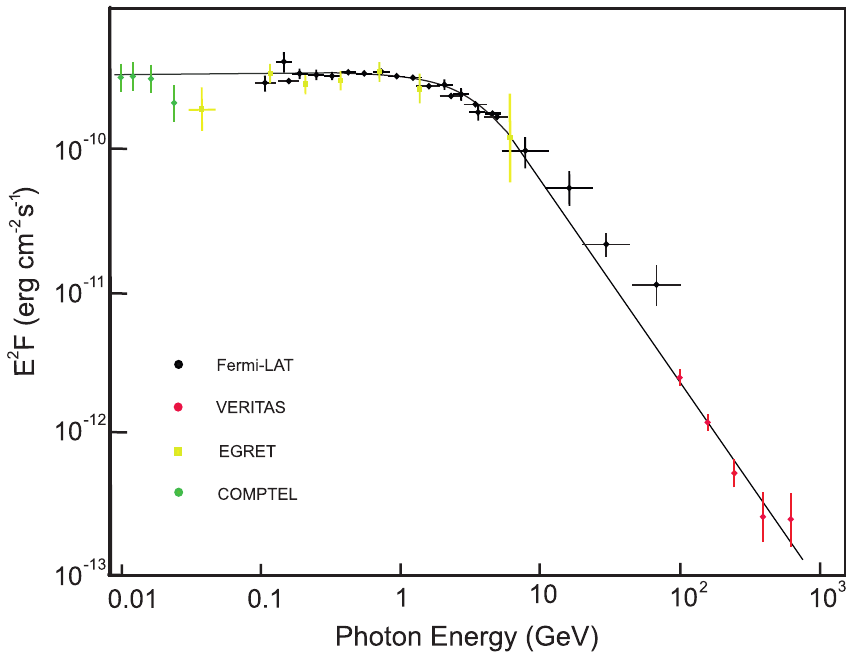
Figure 4. Phase-averaged SED of the Crab pulsar. The black curve represents the broken power-law function with break point at energy 4GeV, defined by Equation (28). The LAT spectral points are from Abdo et al. [14], VERITAS data points from Nguyen [15], and EGRET and COMPTEL measurements are from Kuiper et al. [11],